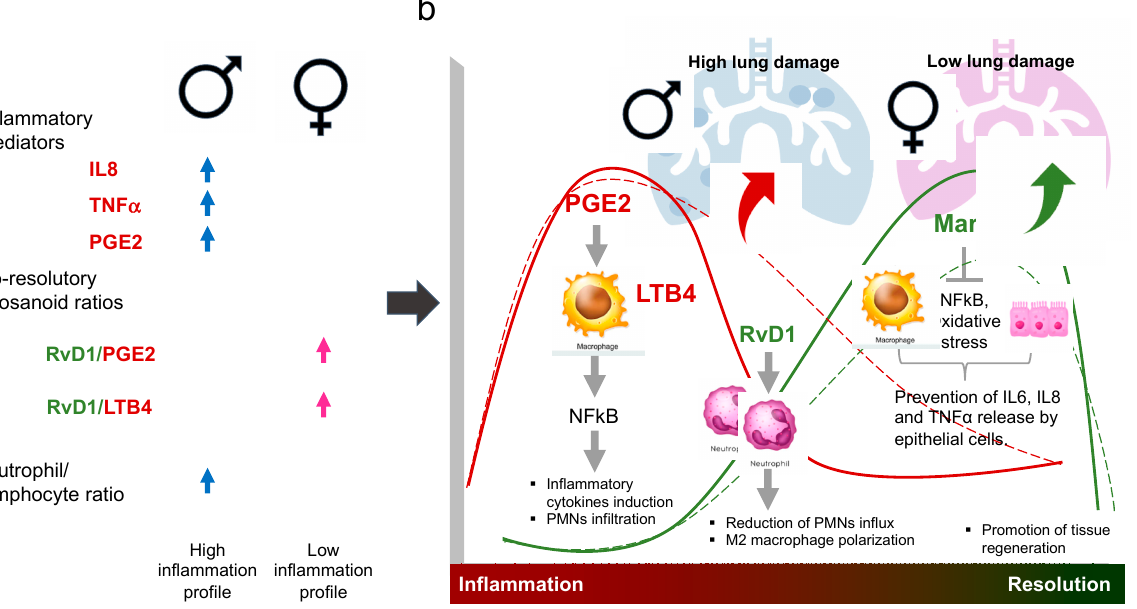
Figure 8. Sex-dependent alterations in inflammation/resolution pathways in active tuberculosis patients. ( a ) Men exhibited a circulating high inflammation profile, whereas women had a pro/resolution profile. ( b ) Implications of our findings. Pro-inflammatory eicosanoids PGE2 and LTB4 induce the production of pro-inflammatory cytokines, which results in neutrophils infiltration. The subsequent production of pro-resolution eicosanoids RvD1 and Mar1 helps to control the cytokine production, reduce the neutrophil infiltration and oxidative stress, and promote tissue regeneration. Dotted lines indicate the more pro-inflammatory profile observed in men, which makes them more susceptible to develop lung damage. The more pro-resolution profile in women (solid lines) may be protective of the lungs.